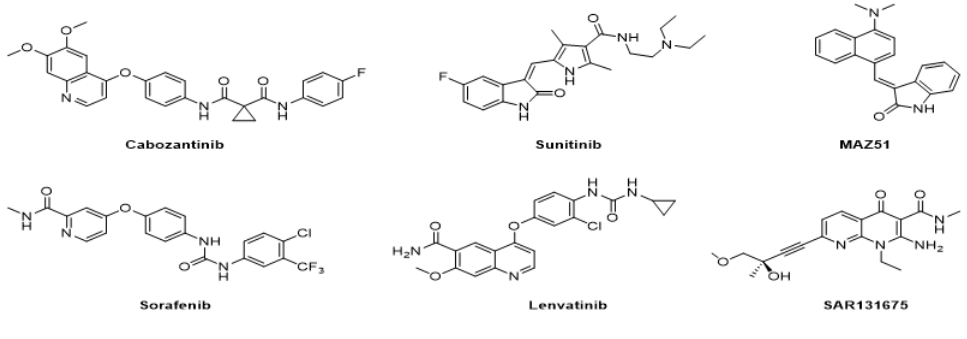
Figure 1. Inhibitors targeting